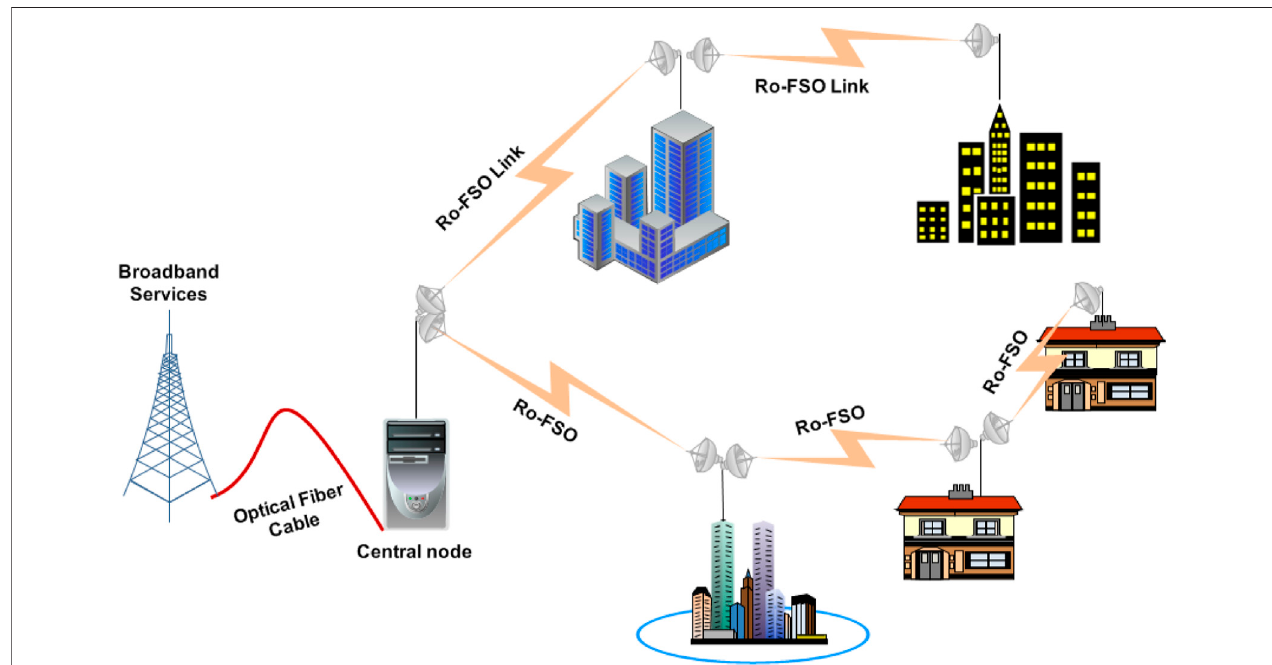
FIGURE 1 | Ro-FSO topology for broadband